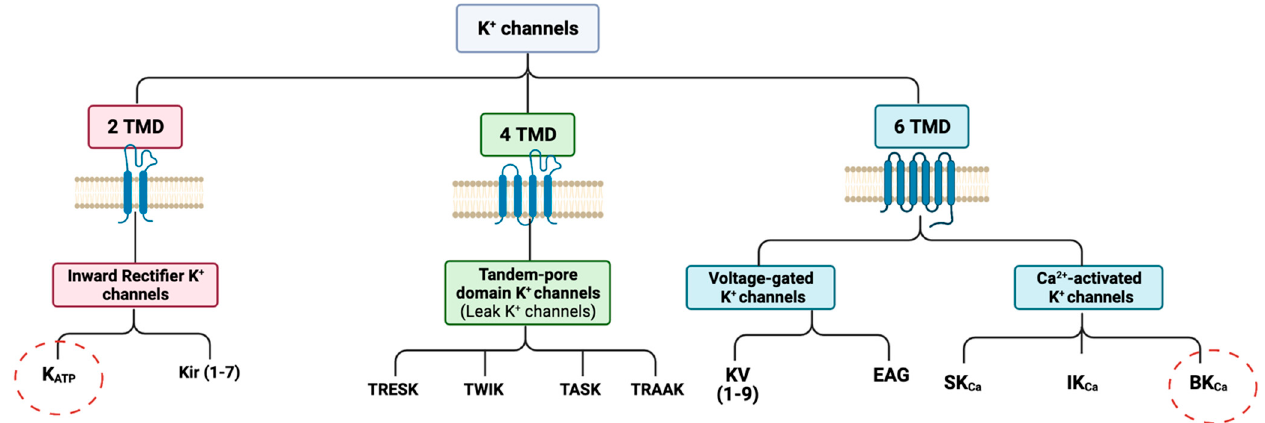
Figure 1. Classification of potassium (K + ) channel family. The K + channels are structurally divided into three subclasses based on the number of transmembrane segments. K + channels with two transmembrane domains (2 TMD) are known as Inward Rectifier K + channels, to which K ATP and Kir channels belong. Tandem-pore domain K + channels, also called ‘leak K + channels’, consist of four transmembrane domains, whereas voltage-gated and calcium-activated K + channels are composed of six transmembrane domains (6 TMD). Furthermore, the calcium-activated K + channels are named according to their calcium conductivity. K ATP = ATP-sensitive potassium channel; Kir = inward rectifying K + channel; TWIK = tandem weak inward rectifying K + channel; TRESK = TWIK-related spinal cord K + channel; TASK = TWIK-related acid-sensitive K + channel; TRAAK = TWIK-related arachidonic acid-activated K + channel; KV = voltage-gated K + channel; EAG = ether-a-go-go K + channel; SK Ca = small conductance calcium-activated K + channel; IK Ca = intermediate conductance calcium-activated K + channel; and BK Ca = big conductance calcium-activated K + channel.